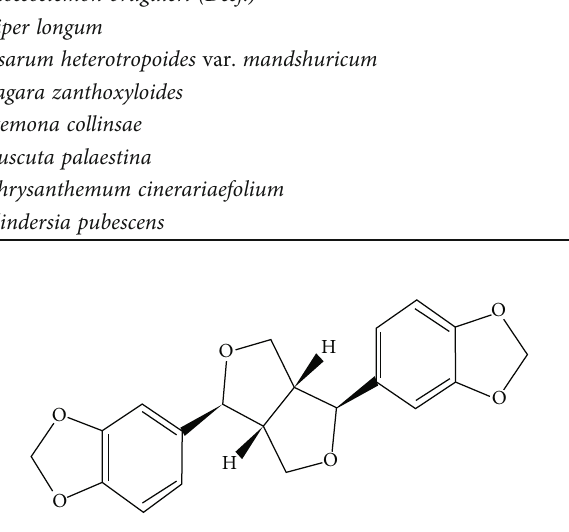
Figure 1: Chemical structure of